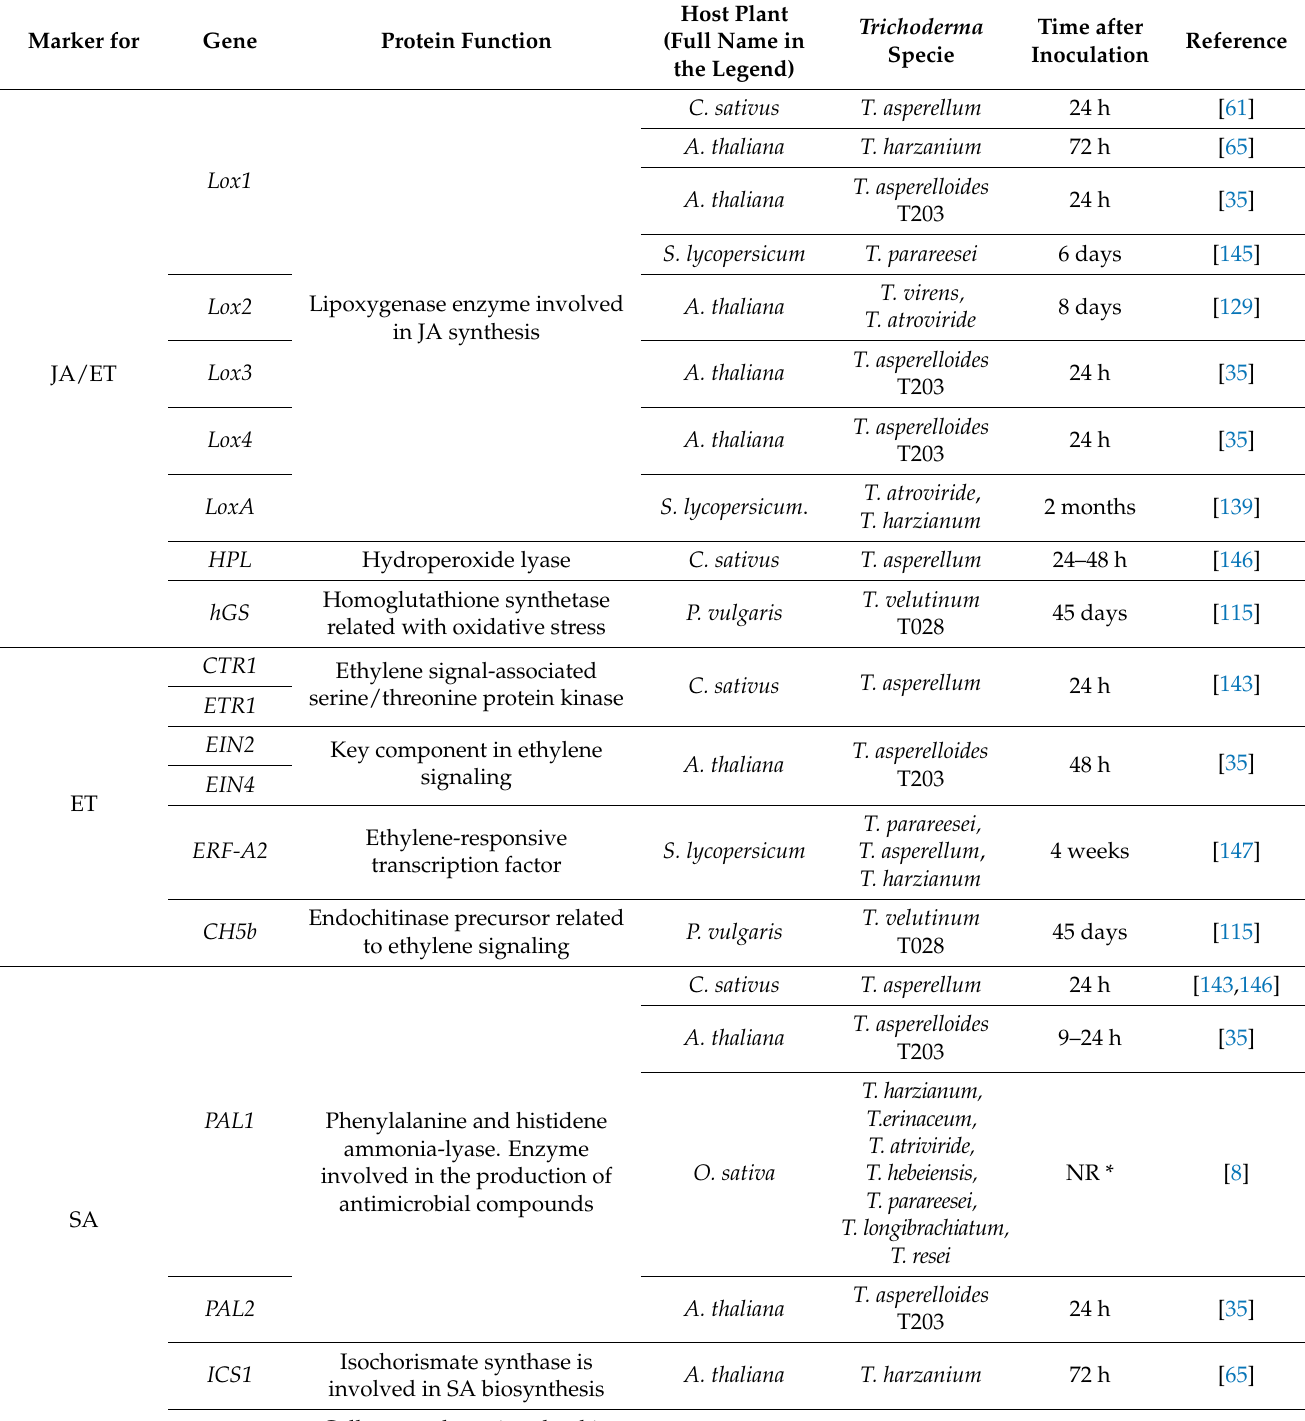
Table 3. Expression of gene markers positively regulated by Trichoderma